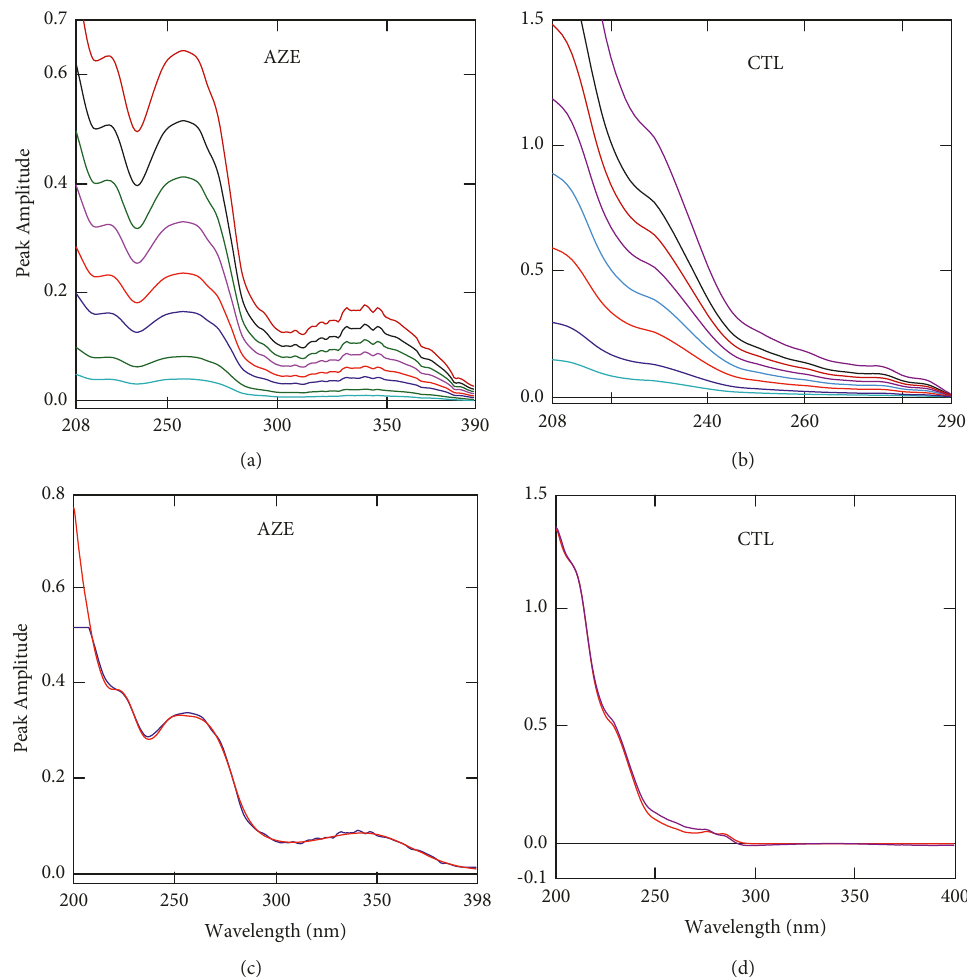
Figure 5: (a) Zero-order spectra of CTL (1–15 μ g/mL). (b) Zero-order spectra of AZE (1–15 μ g/mL). (c) Comparison of zero-order spectra of pure CTL (red) and mixture (blue). (d) Comparison of zero-order spectra of pure AZE (red) and mixture (blue). Table 1: Validation parameter results of the proposed spectroscopic methods for the simultaneous determination of CTL and AZE. Validation